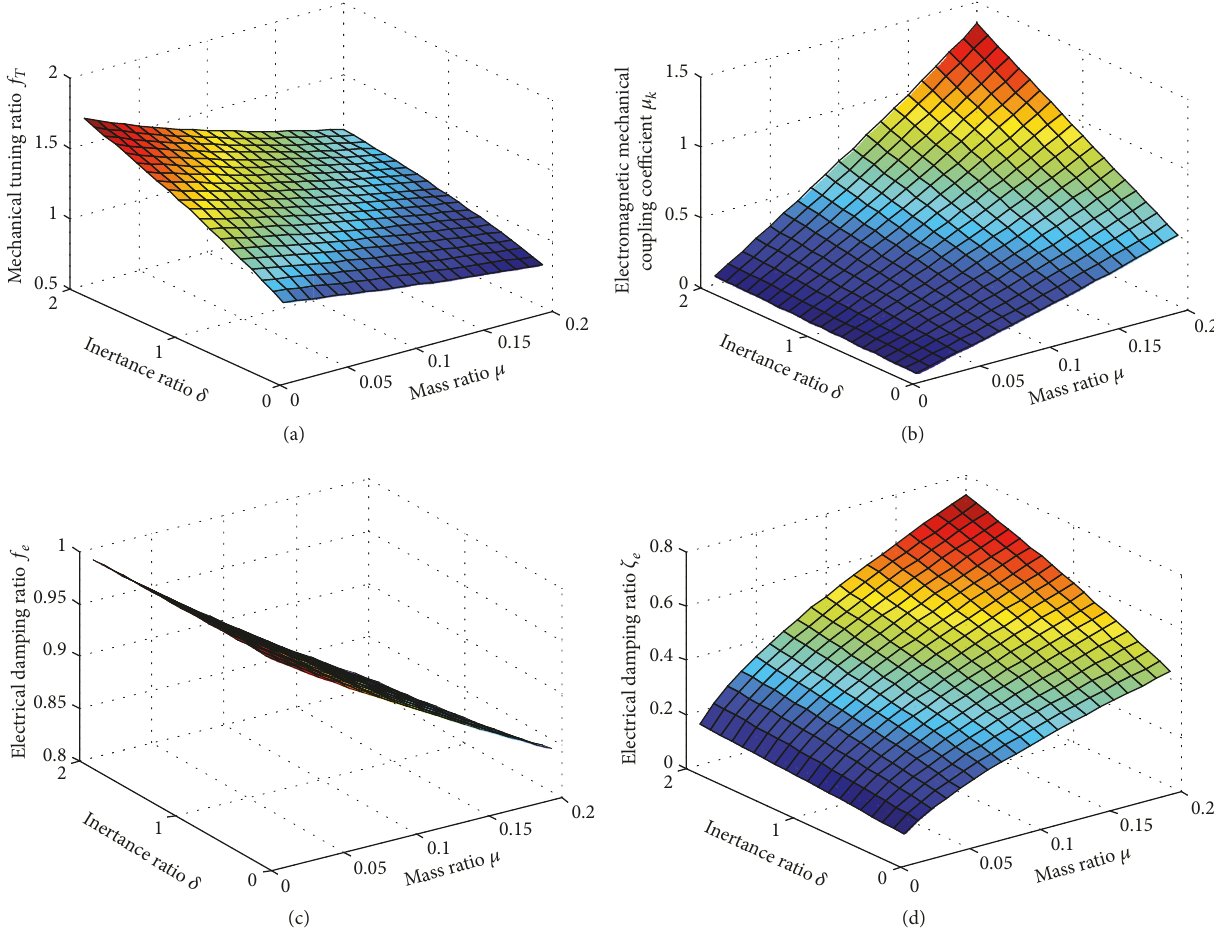
Figure 3: Three-dimensional graphical representations of 𝐻 2 tuning laws. (a) Optimal mechanical tuning ratio 𝑓 𝑇 , (b) optimal electromagnetic mechanical coupling coefficient 𝜇 𝑘 , (c) optimal electrical tuning ratio 𝑓 𝑒 , and (d) optimal electrical damping ratio 𝜁 𝑒 of approximate solutions.